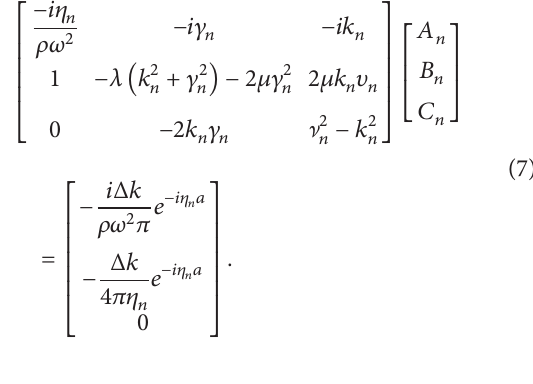
where 𝜌 𝐹 is density of the fluid, 𝑎 is the distance between the source and the interface, and 𝐴 𝑛 represents the diffraction coefficient for the fluid to be